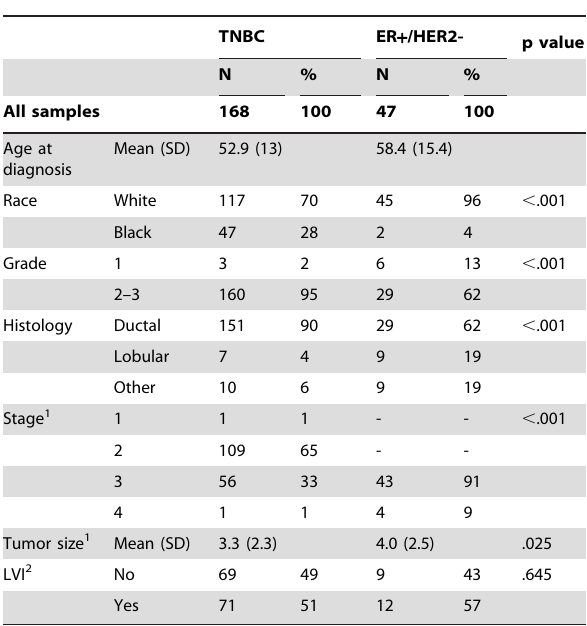
Table 1. Patient